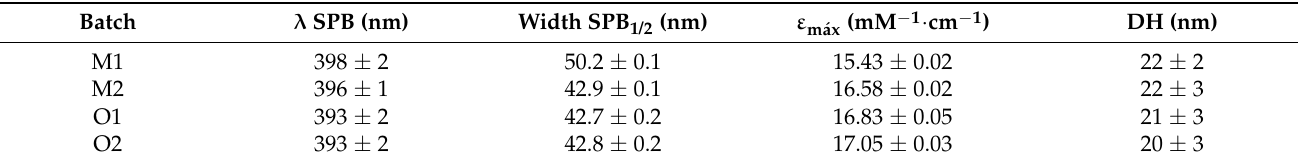
Table 2. Wavelength values ( λ ) of SPB, width of the peak at half the maximum, extinction coefficient ( ε m á x ) obtained by UV-Vis spectroscopy and hydrodynamic diameter (DH) for different commercial batches of AgNPs.